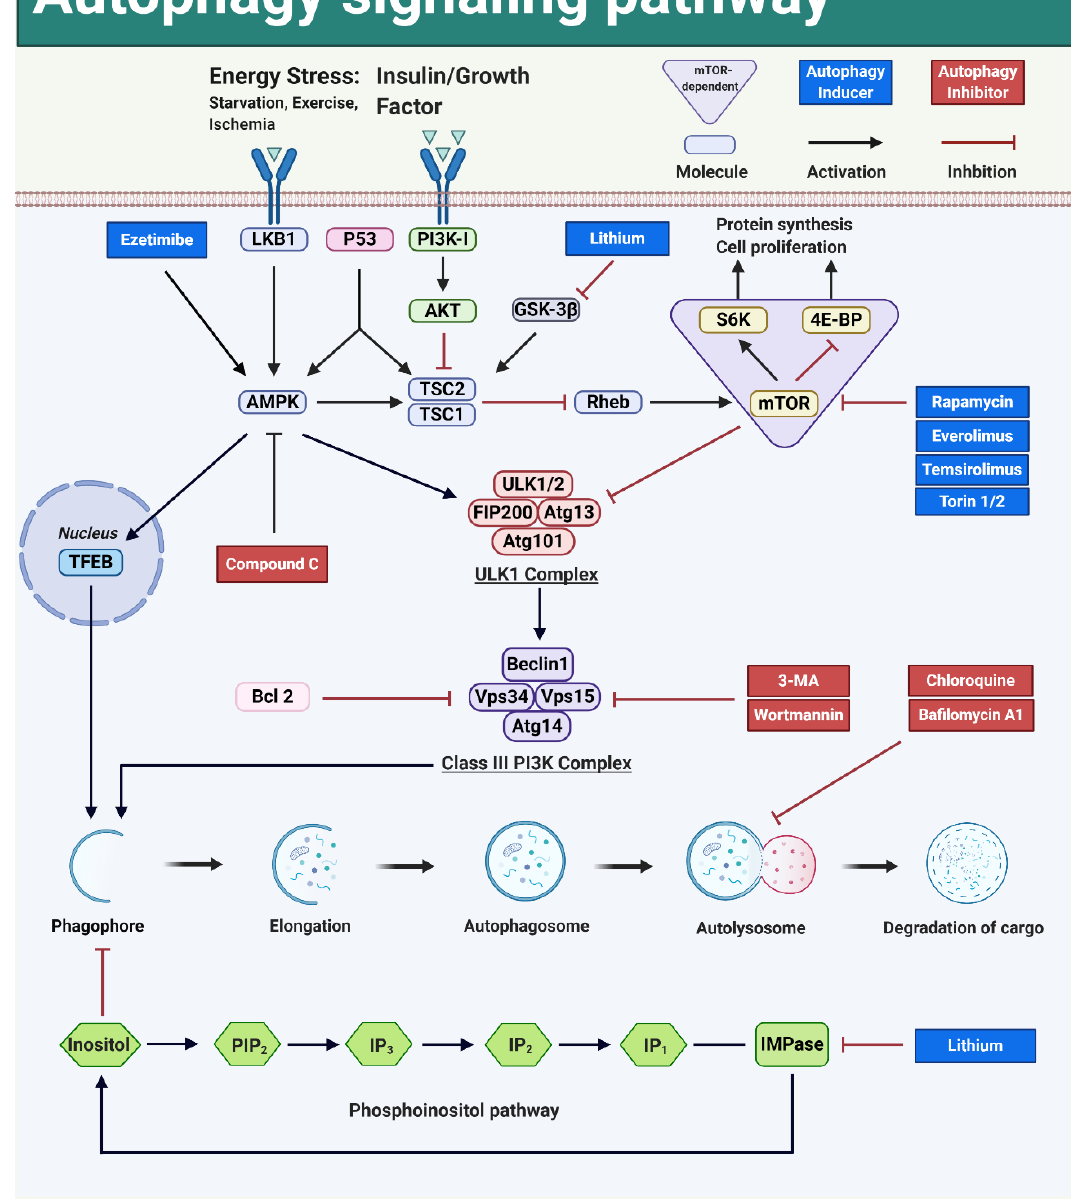
Figure 3. Signaling pathways and modulators involved in the regulation of macroautophagy. mTOR is a key regulator for both autophagy and cell proliferation. Autophagy can be activated in the mTOR-dependent and the mTOR-independent signaling pathways. Dark blue square: autophagy inducer; Dark red square: autophagy inhibitor.